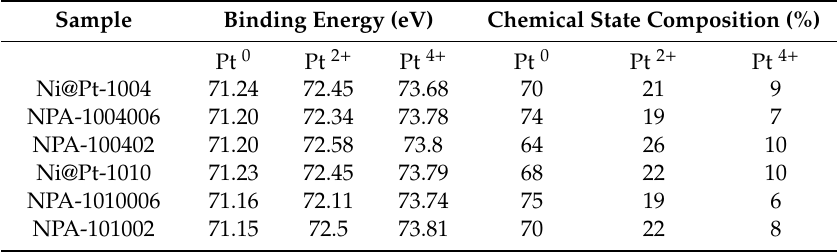
Figure 3. X-ray photoemission spectroscopy of experimental nanocatalysts (NCs). ( a ) Pt-4f / Ni-3p orbitals of Ni@Pt-1004, NPA-1004006, and NPA-100402. ( b ) Pt-4f / Ni-3p orbitals of Ni@Pt-1010, NPA-1010006, and NPA-101002. Table 2. Comparative XPS-determined composition ratios and binding energies of experimental